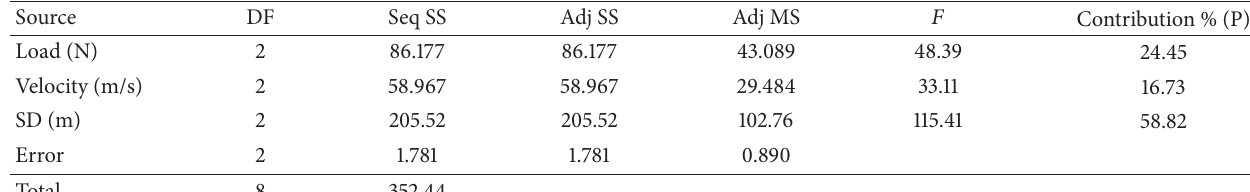
Table 6: Analysis of variance table for wear